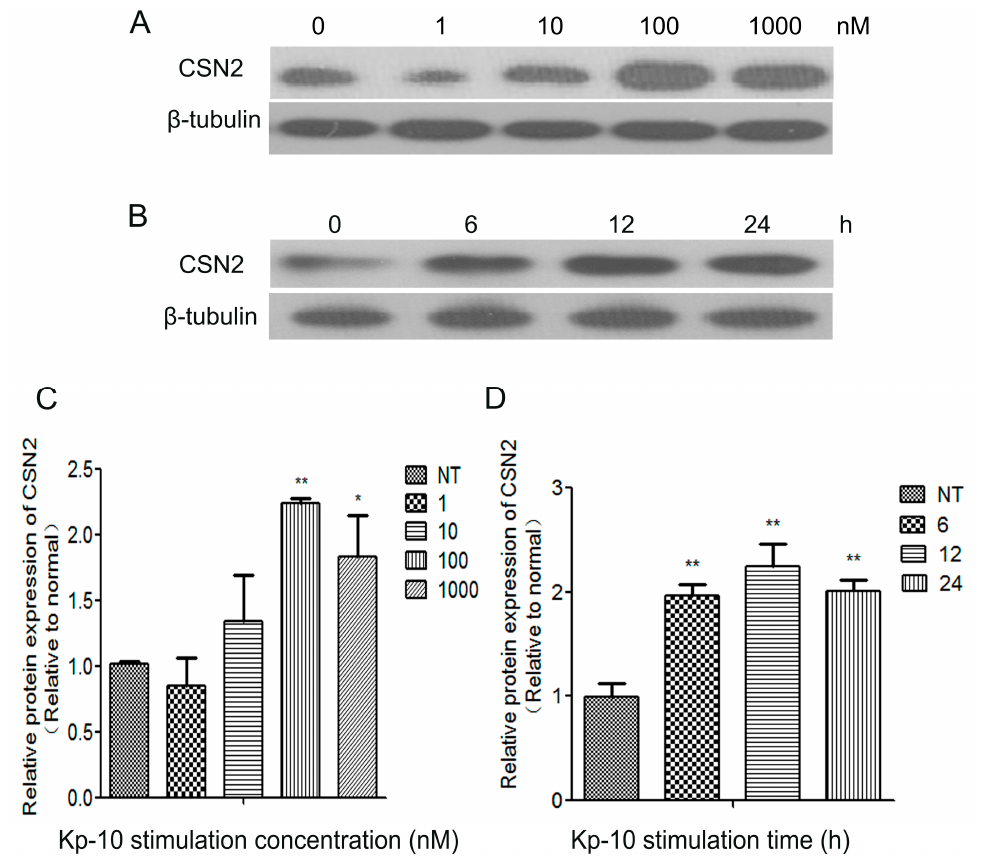
Figure 3. Kp-10 promoted CSN2 protein expression in bMECs. ( A , C ) Cells were incubated for 12 h with different concentrations of Kp-10 (0, 1, 10, 100 and 1000 nM); ( B , D ) cells were incubated with 100 nM Kp-10 for different periods (0, 6, 12 and 24 h), and protein expression of CSN2 was examined by Western blot; ( C , D ), the relative protein levels were quantified by scanning densitometry and normalized to β -tubulin. The data is presented as the means ± S.D. ( n = 3; * p < 0.05, ** p < 0.01 vs. non-treated (NT) control group).